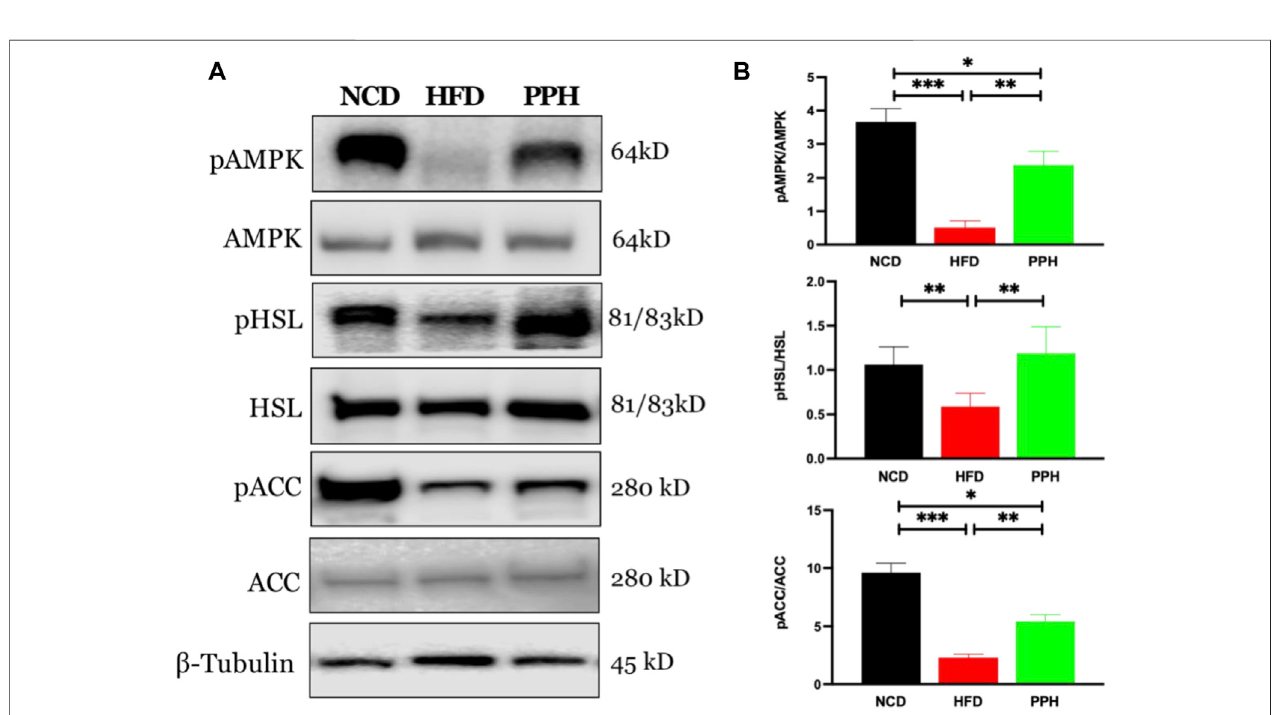
Frontiers in Pharmacology |